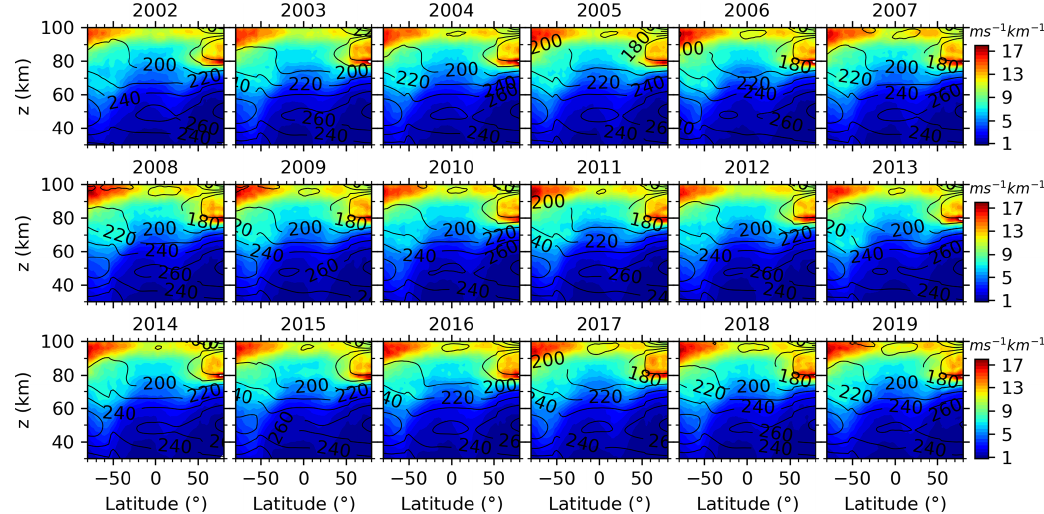
Figure 8. Latitude–height contours of the zonal-mean GW-perturbed wind shears (color-filled contour) and temperature (contour lines) during each summer from 2002 to 2019. All panels have the same color scales with units of ms − 1 km − 1 . All panels have the same x -axis and y -axis